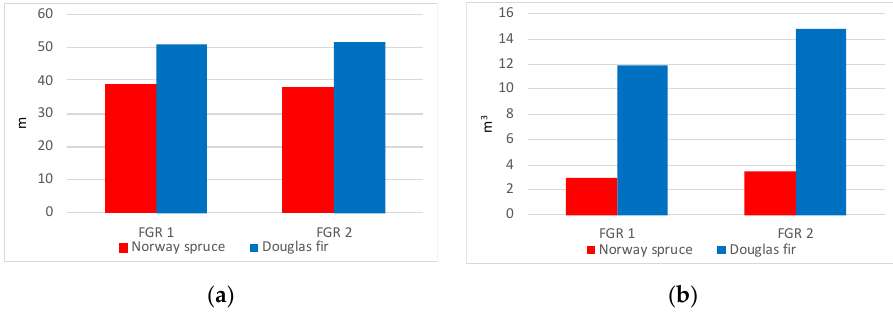
Figure 1. Total height ( a ) and volume/tree ( b ) of Douglas fir (DU) and Norway spruce (NS) in forest genetics resources (FGR) located in western Romania.